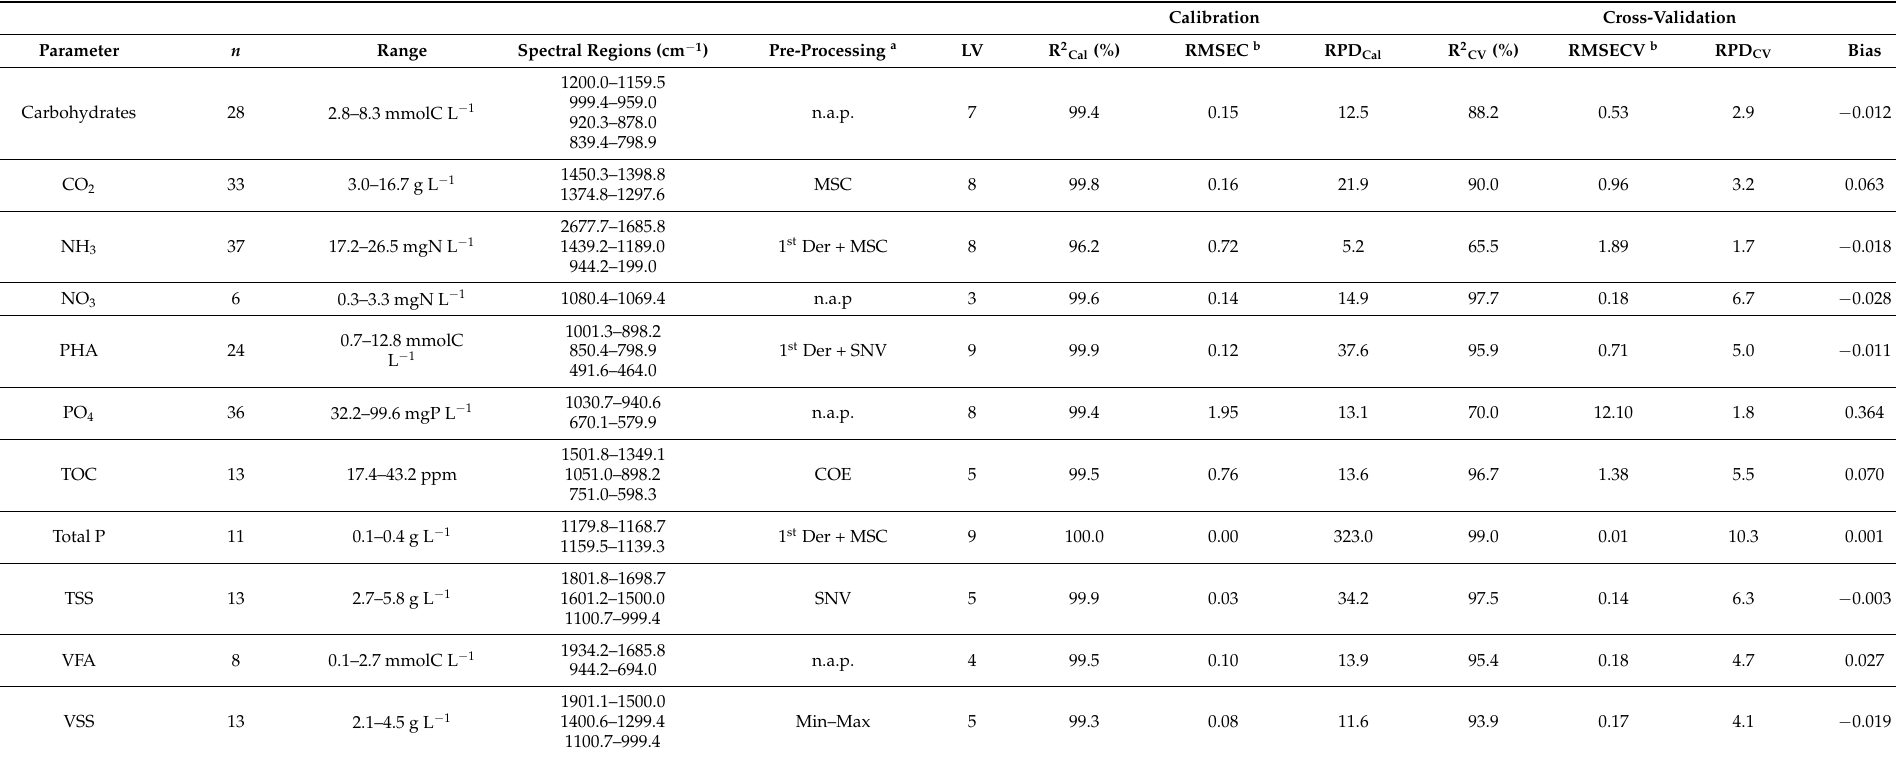
Table 1. Raman-PLS models developed for each studied parameter, within the indicated concentration range: total carbohydrates, carbon dioxide (CO 2 ), ammonia (NH 3 ), nitrate (NO 3 ), polyhydroxyalkanoates (PHAs), phosphate (PO 4 ), total organic content (TOC), total phosphorus (total P), total suspended solids (TSSs), volatile fatty acids (VFAs), and volatile suspended solids (VSSs). For each parameter, the optimized pre-processing strategy, spectral regions, and number of latent variables (LVs) used in the selected model are indicated, along with the respective statistical results from the calibration (coefficient of determination of calibration, R 2 Cal ; root mean square error of calibration, RMSEC; residual prediction deviation of calibration, RPD Cal ) and the full (leave-one-out) cross-validation (coefficient of determination of cross-validation, R 2 CV ; root mean square error of cross-validation, RMSECV; residual prediction deviation of cross-validation, RPD CV ; Bias) obtained during the prediction of the indicated parameters. The number of samples included in the calibration set ( n ) of each calibration model is indicated for each